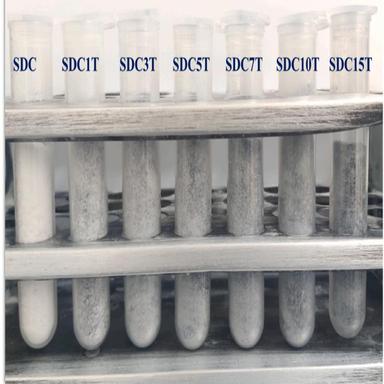
The composite phase change materials containing Ti4O7 particles with different mass fractions.